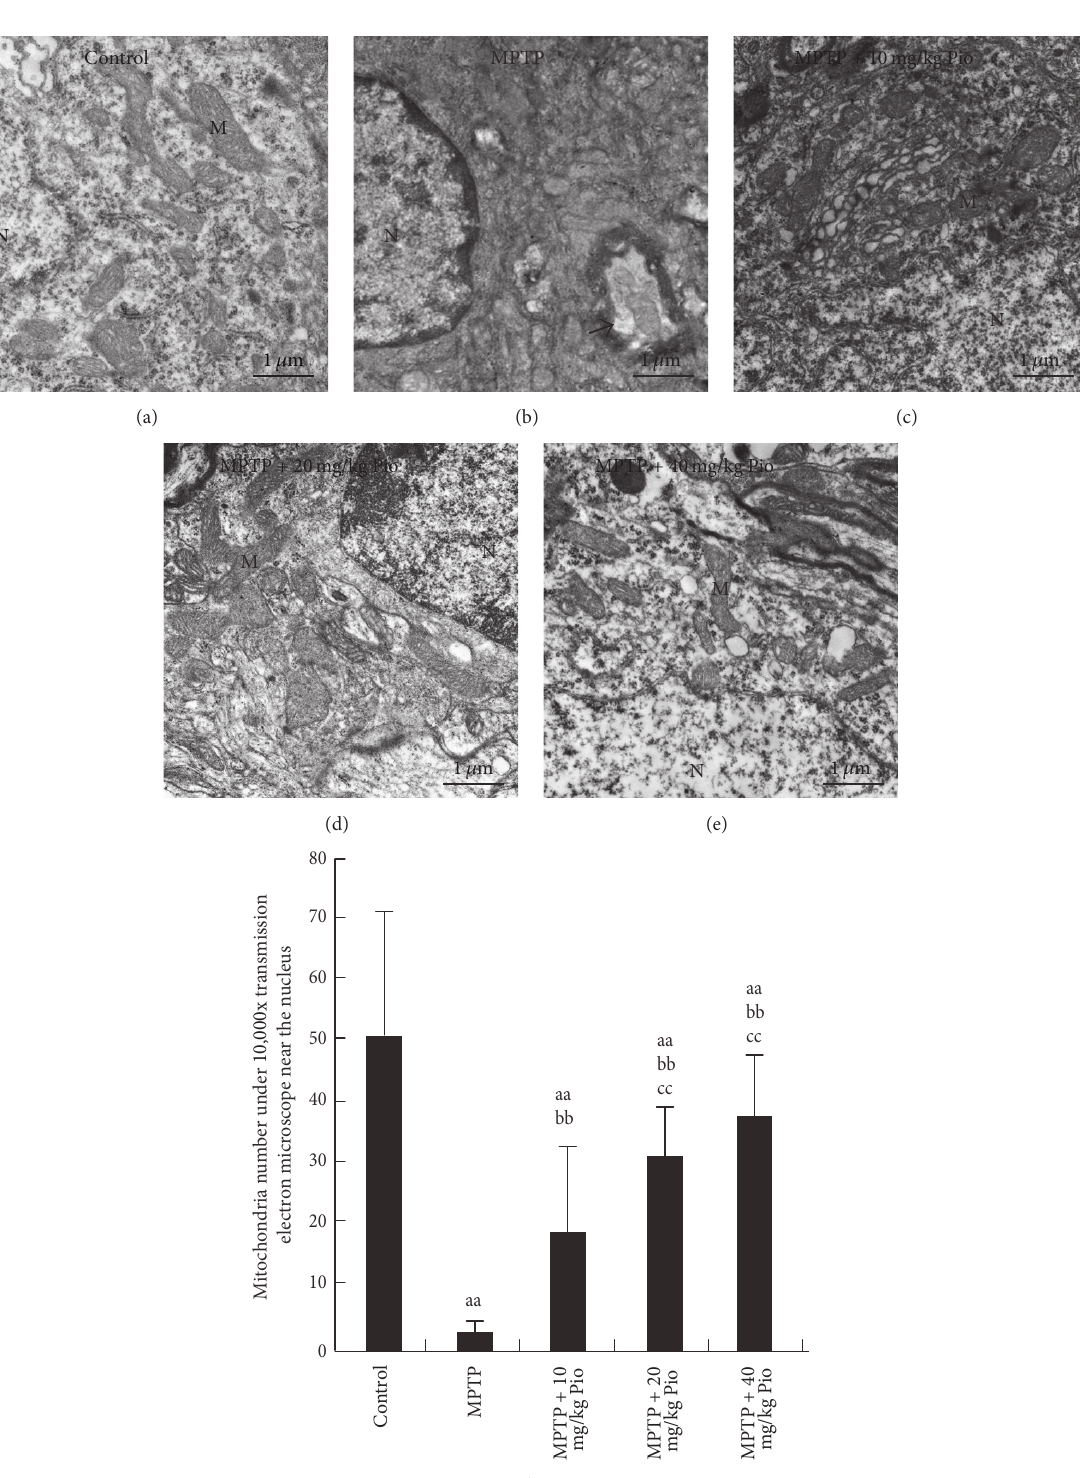
Figure 4: Effect of pioglitazone on the mitochondrial ultrastructure in SNc of MPTP C57BL/6 mice. “aa” indicates 𝑃 < 0.01 , compared with control group; “bb” indicates 𝑃 < 0.01 , compared with MPP + group; “cc” indicates 𝑃 < 0.01 , compared with 0.01 𝜇 mol/L 2,4-TZD group. N indicates nucleus; M indicates mitochondria. Arrow points to the demyelination in (b). The bars in (a)–(e) indicate 1 𝜇